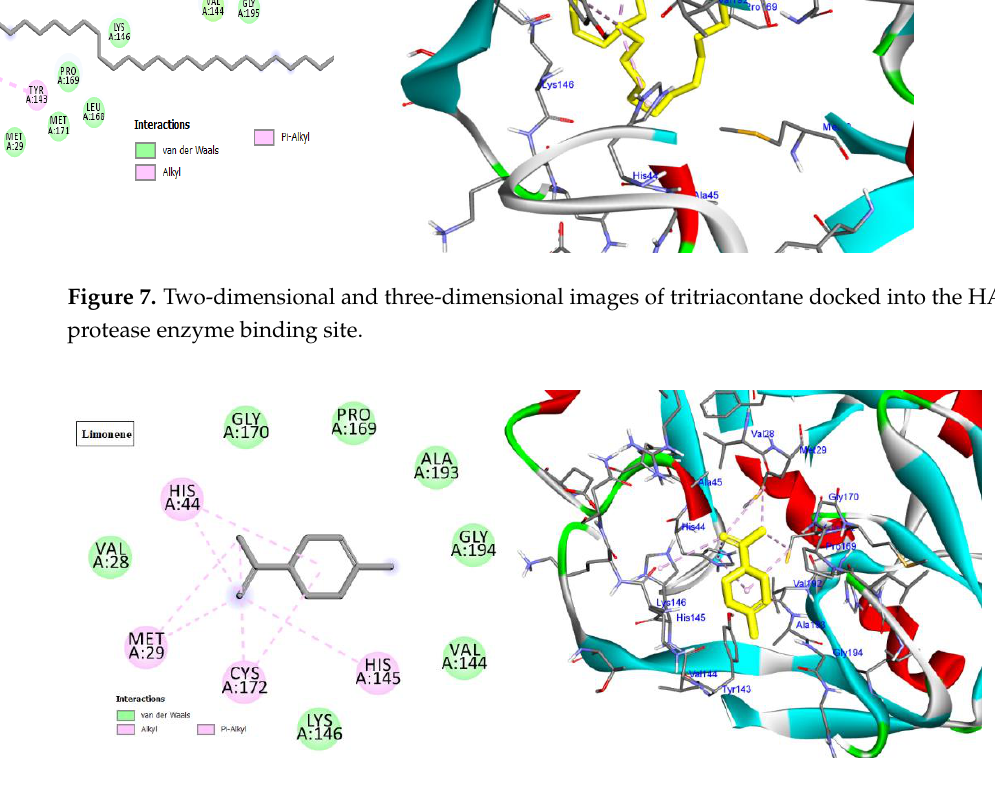
Figure 9. Two-dimensional and three-dimensional images of 13,17-dimethyltritriacontane docked into the HAV 3C protease enzyme binding site. Figure 10. Two-dimensional and three-dimensional images of inhibitor drug (Z10325150) docked into the HAV 3C protease enzyme binding site. 3. Discussion Viral infections continue to be a major cause of morbidity and mortality around the world. With more organ transplants, blood transfusions, and the use of hypodermic sy- ringes, the number of patients diagnosed with viral infections rises alarmingly each year. Traditional antiviral drugs, such as ribavirin and interferon, are effective in vitro against